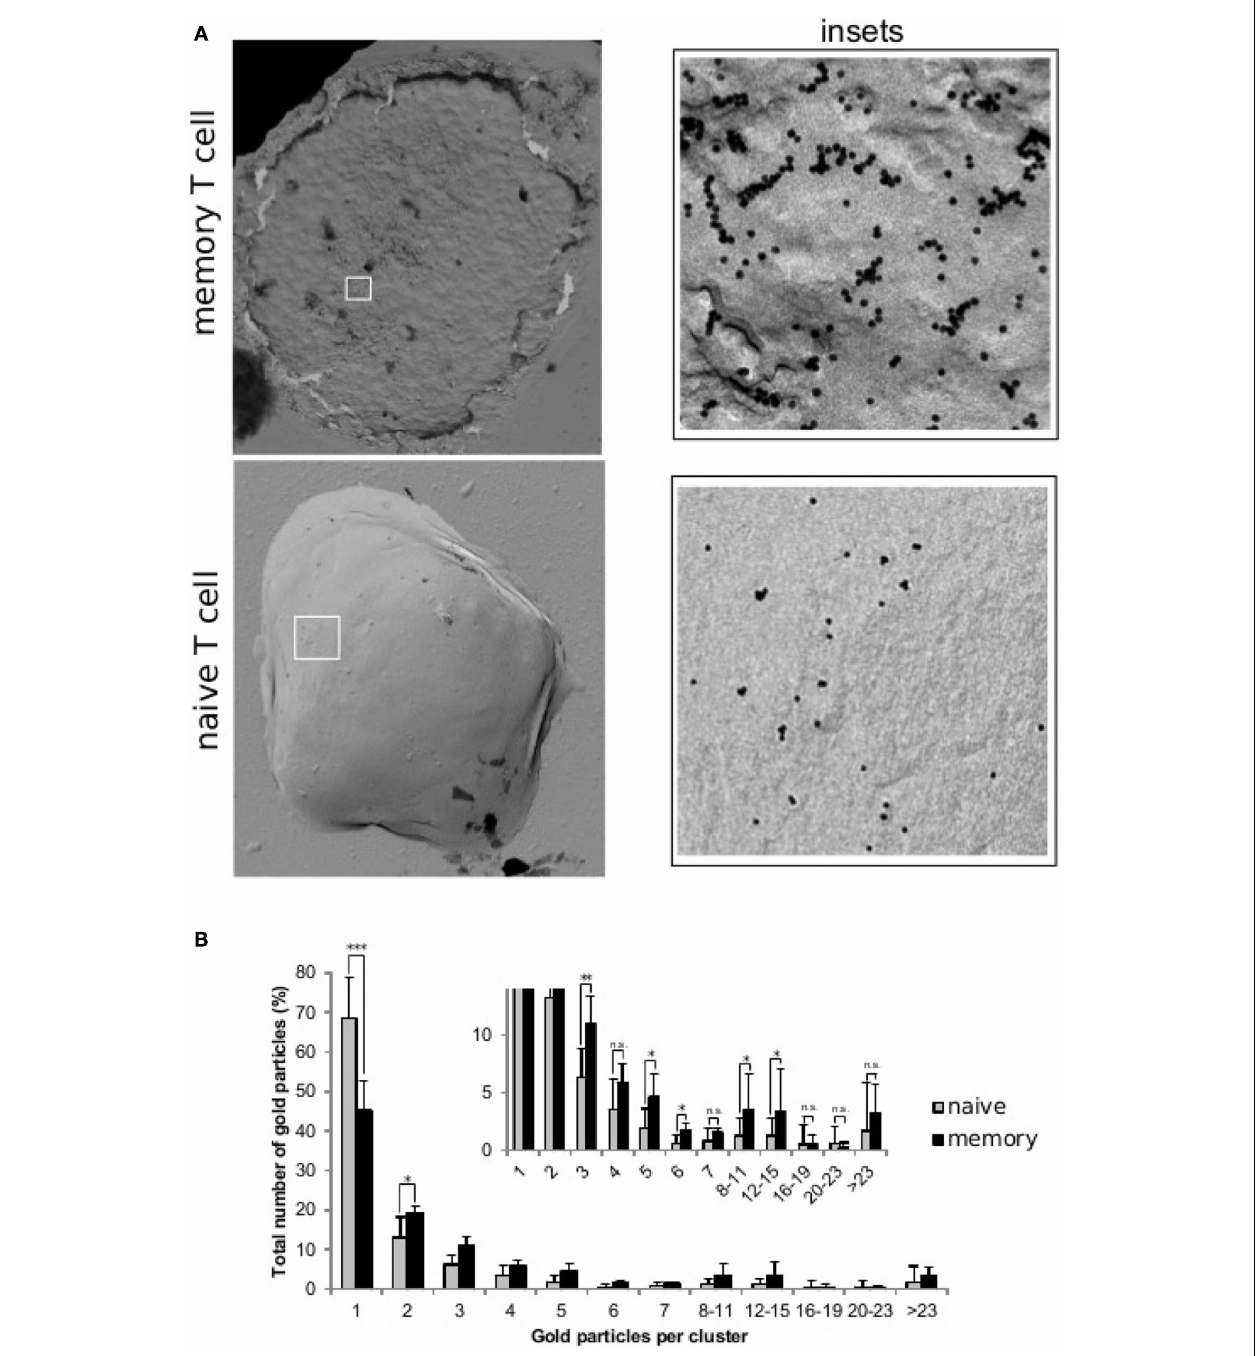
sizes for resting naiveT cells (gray bars, 7 cells, 9190 particles) and memoryT cells (black bars, 5 cells, 3001 particles).The inset shows a detailed view of the distribution of clusters of three or more gold particles and statistical analysis (2-tailed Student’s t -test: * p < 0.05, ** p < 0.01, and *** p < 0.001). All naive and memoryT cells had clusters with gold. However, whereas in naiveT cells the maximum gold cluster size shared by all cells was four, this was eight for memoryT cells. Also clusters bigger than twenty three particles were present in four out of five memoryT cells, and only two out of seven naiveT